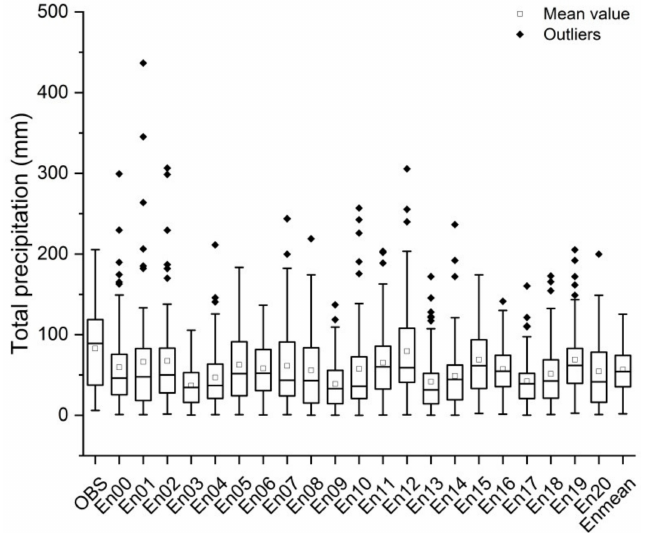
Figure 3. Total cumulative precipitation of all stations as well as the associated WRF ensembles. Thick horizontal lines in boxes showed the median values. Boxes indicated the inner-quartile (25% to 75%) and the whiskers showed the full range of the values. The hollow rectangles presented the mean values, and the solid diamonds presented the